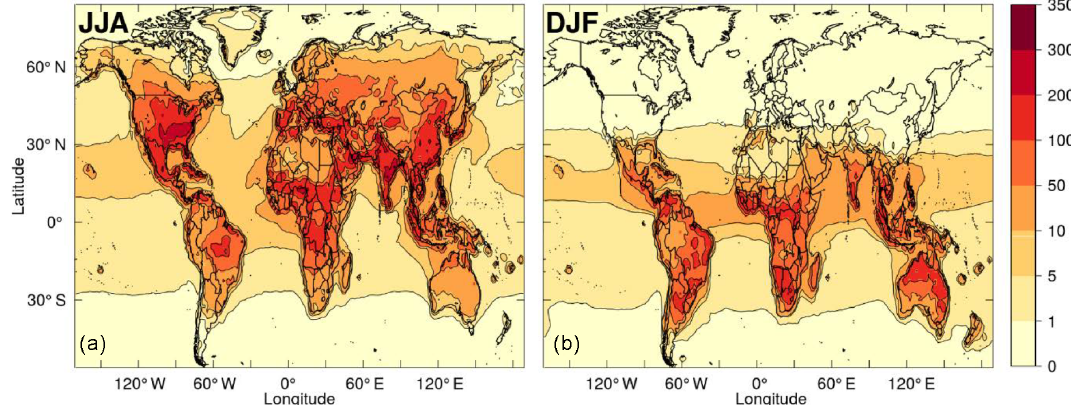
Figure 9. Modelled mean diurnal peak ROOOH volume mixing ratio (in ppt) during northern (a) and southern (b) summer months, using a combined removal rate for all ROOOH of 10 − 4 s − 1 .